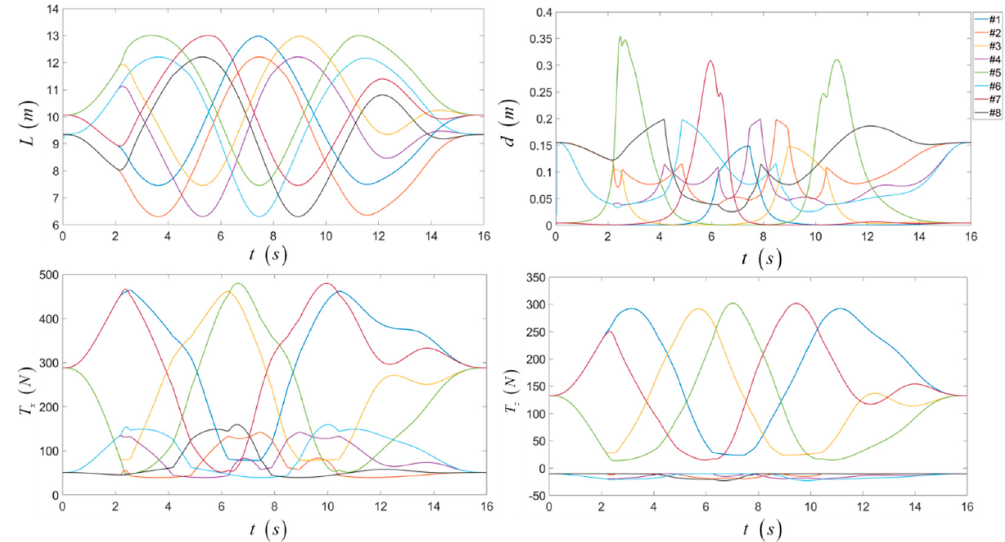
Figure 21. Unstrained length L , adjusting length d , tension along X -axis T x and tension along Z -axis T z Figure 21. unstrained length L , adjusting length d , tension along X -axis respect to { A } of CDPM that has the second configuration during the simulation test. { } A of CDPM that has the second configuration during the simulation test. T respect to axis z